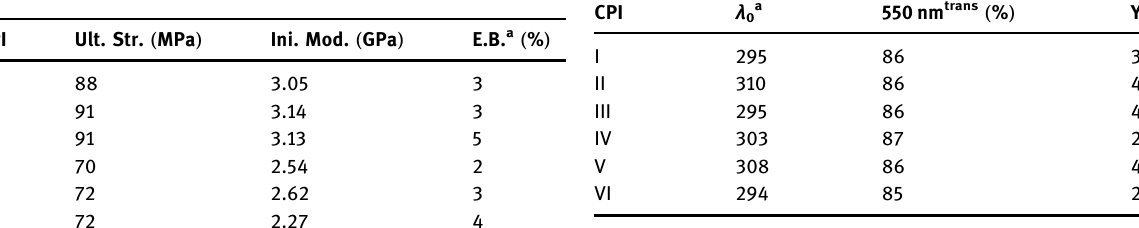
Table 5: Optical properties of CPI fi lms obtained from the